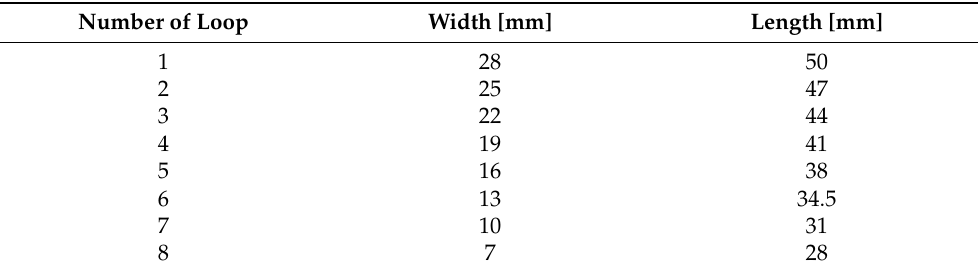
Table 1. Dimensions of rectangular loops in the